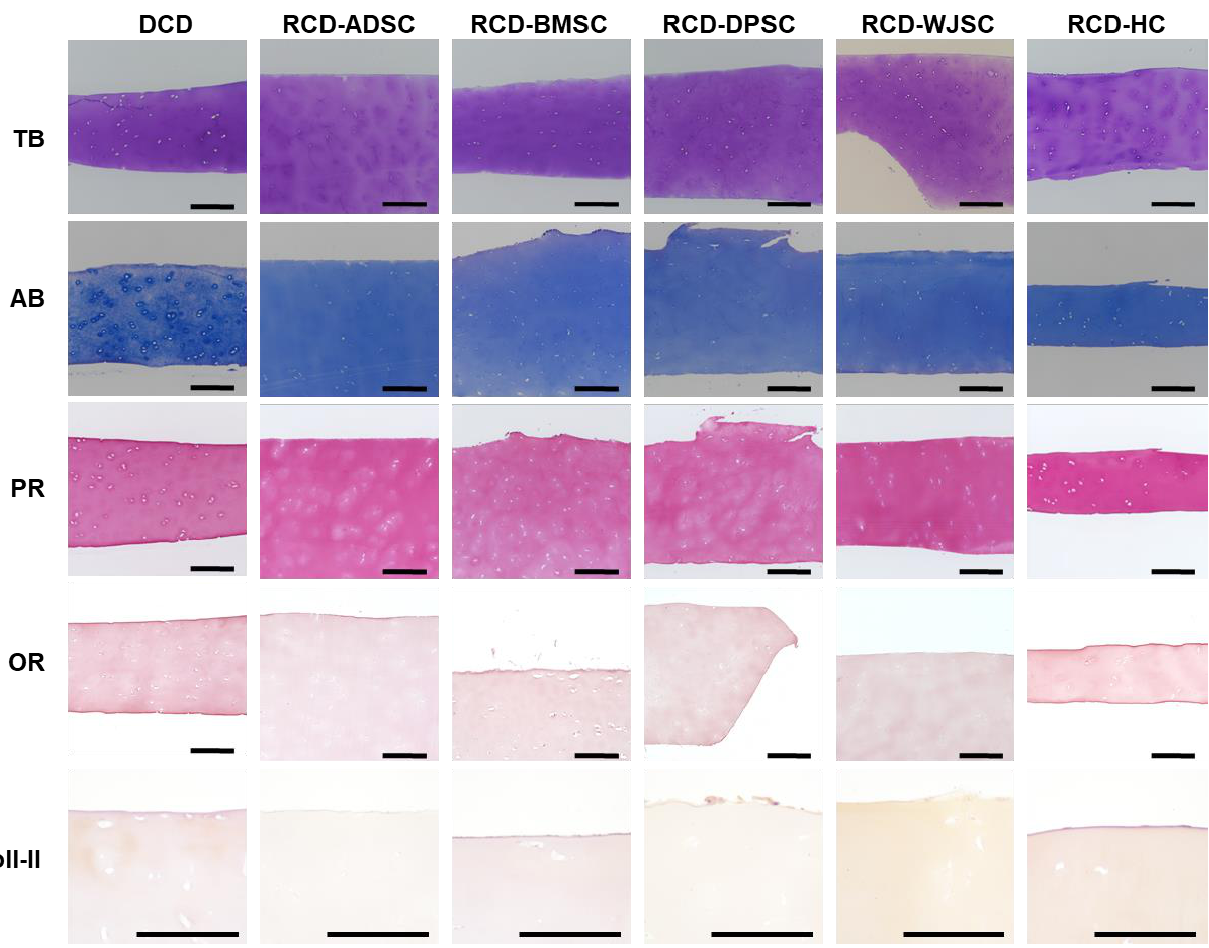
Figure 6. Histochemical and immunohistochemical analysis of the extracellular matrix in RCD maintained in ex vivo culture using TB, AB, PR and OR histochemistry and Coll-II immunohistochemistry. DCD are shown again at the left side for comparative purposes. Scale bars: 200 µm.